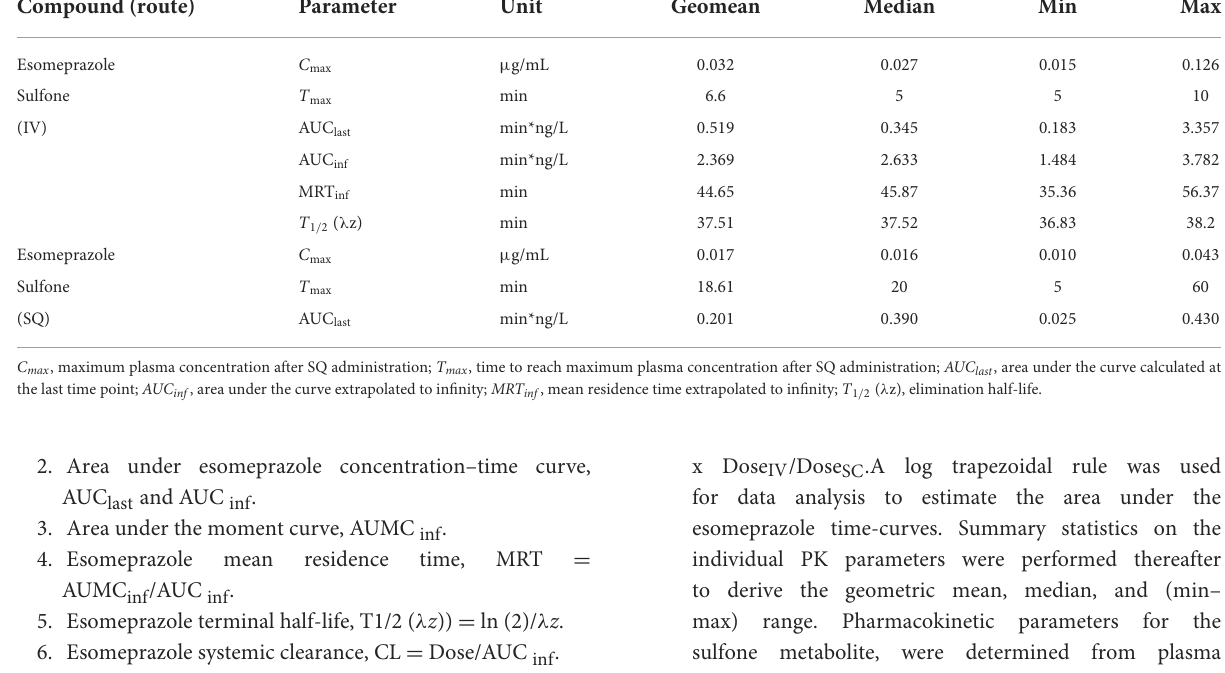
TABLE 2 Pharmacokinetic parameters of esomeprazole sulfone after single dose intravenous (IV: 1 mg/kg) and subcutaneous (SC: 2 mg/kg) administration of esomeprazole in goats ( n = 5). Compound